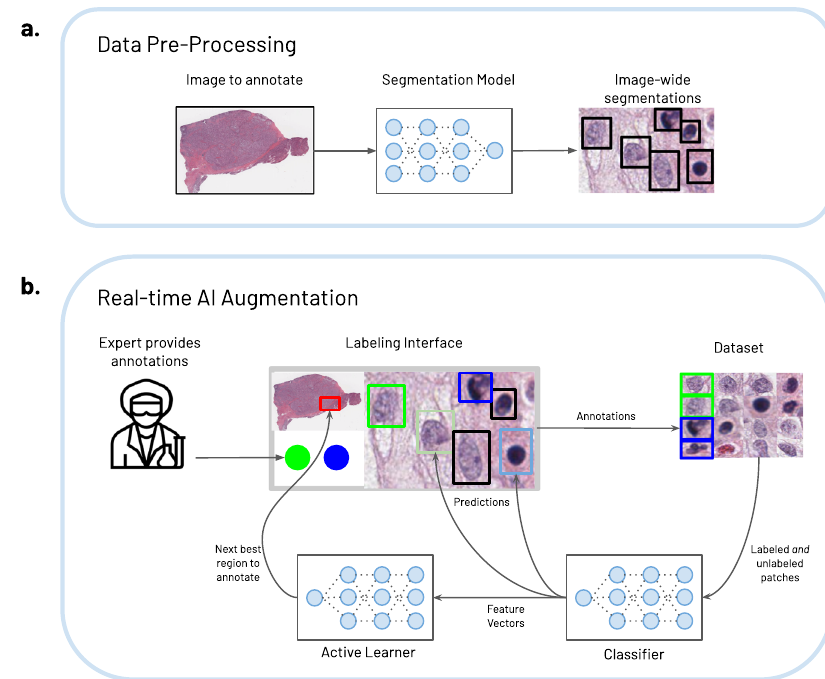
Fig. 2 System architecture. a Data pre-processing. Digital images are fi rst pre-processed by passing through a deep learning model (HoverNet 9 ), which segments and generates bounding boxes for each cell. The image and bounding boxes are then used in real-time via a labeling interface out fi tted with two AI models that serve to augment and accelerate expert labeling ( b ). Real-time AI augmentation. As annotators provide cellular labels (bright green/blue boxes denote different classes), they are stored in a data set and iteratively used to fi netune a ResNet classi fi cation 22 model, pre-trained on the PanNuke cellular data set, but initially untrained on the task at hand. As the classi fi er learns the annotations, it renders ever more accurate predictions (pastel green/blue boxes) to the annotator. Simultaneously, it feeds in high-dimensional feature vector representations of the labeled and unlabeled data set to the active learner, which determines the next best patch that an annotator should label. Together they increase the speed of annotation and the quality of the labeled data